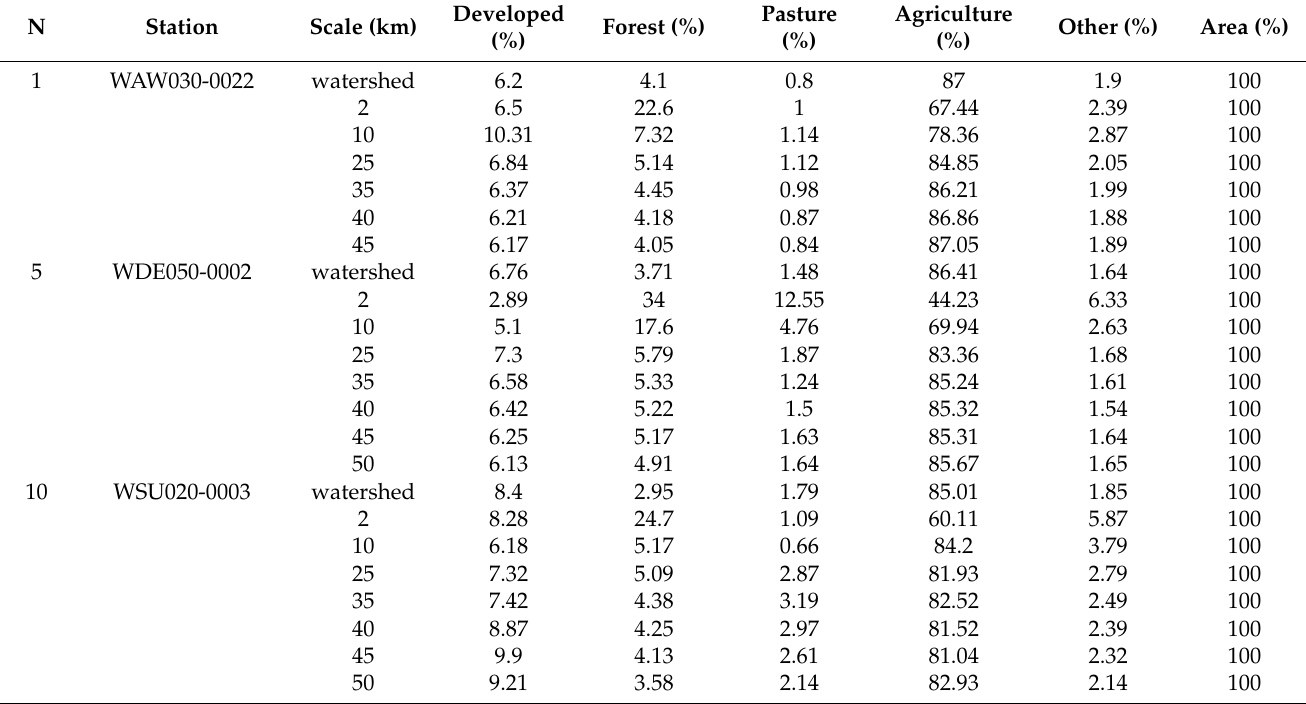
Table 2. Land use percentages [45] for different reach distances at the water quality stations in the year 2001. Agriculture Developed Forest (%) Pasture (%) N Station Scale (km) N Station Scale (km) (%) (%)